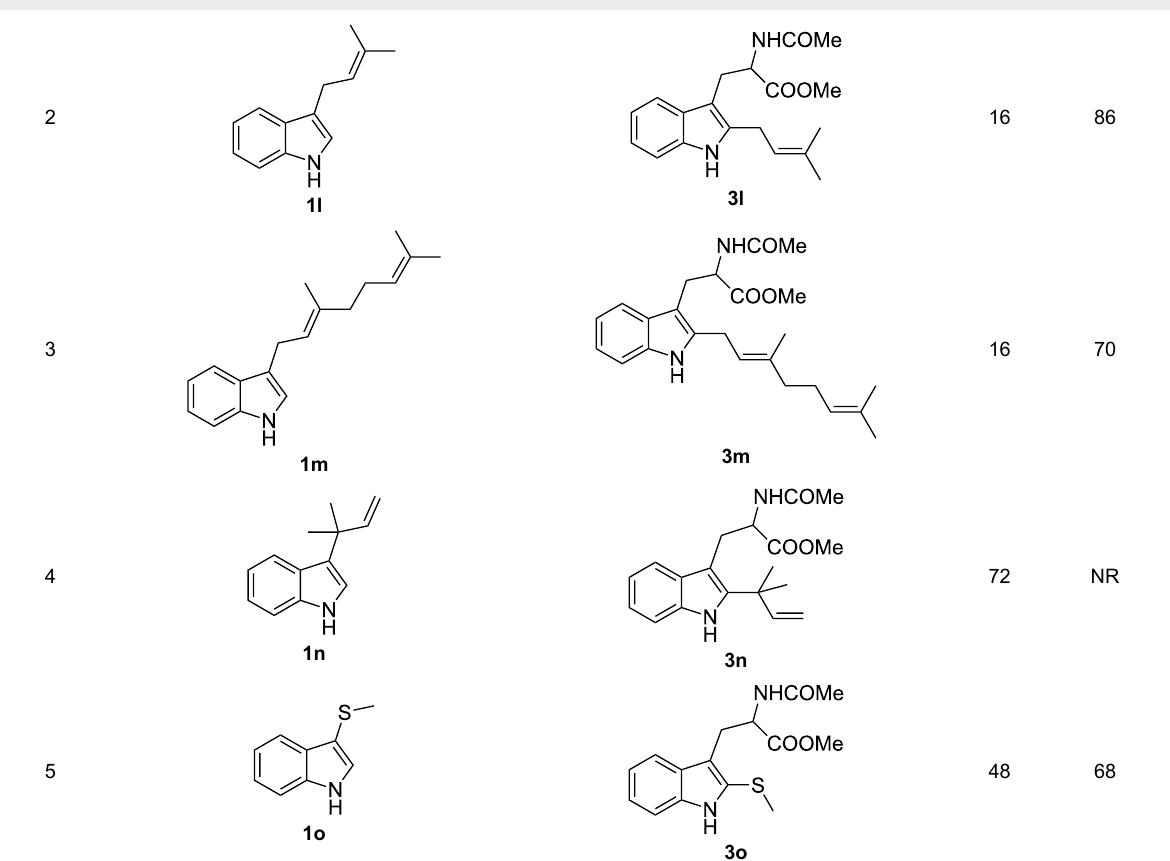
Table 3: Synthesis of 2-allyltryptophans 3k–o . a